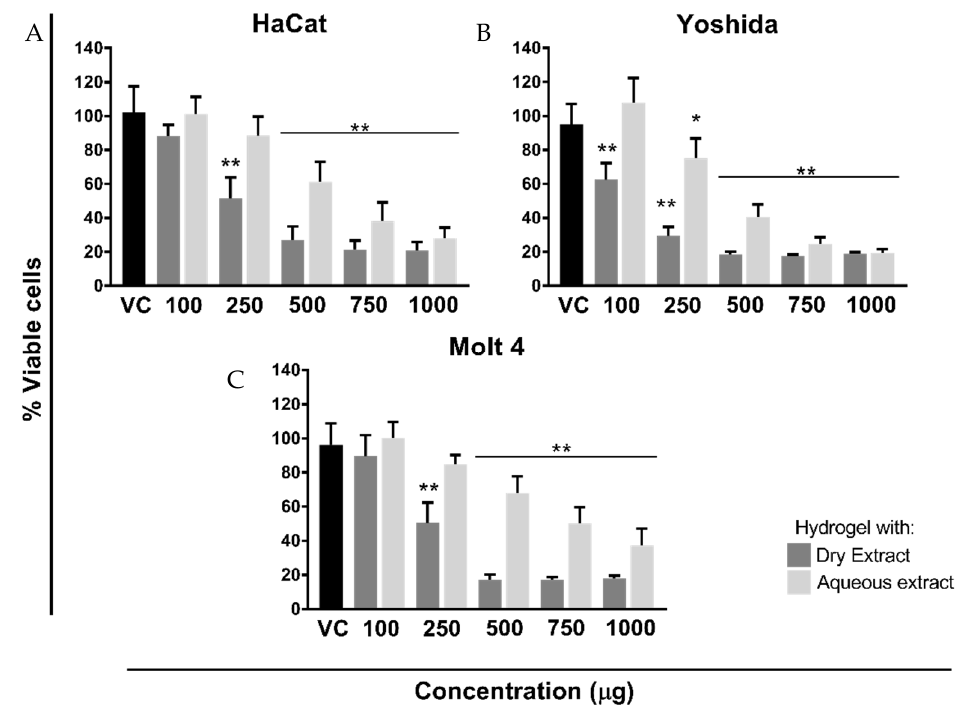
Figure 4. Dose response effect of the hydrogel containing V. album dry and aqueous extract on different cell lines proliferation after 24 h of treatment. Cell growth was assessed with WST-1 colorimetric assay, after 1:30 h of incubation. ( A ) HaCat: non-tumoral, adherent; ( B ) Yoshida: tumoral, adherent; ( C ) Molt-4: tumoral, non-adherent. The extract (dry or aqueous) concentration varied between 100, 250, 500, 750 and 1000 µg, corresponding to 2, 5, 10, 15, and 20 mg of hydrogel, respectively. Vector control (VC; hydrogel without extract) was used at a concentration of 20 mg. Results are presented as mean ± SD from three independent experiments in comparison to the VC. * p < 0.05; ** p < 0.0001, obtained with ordinary one-way ANOVA with Tukey’s multiple comparisons post-test.